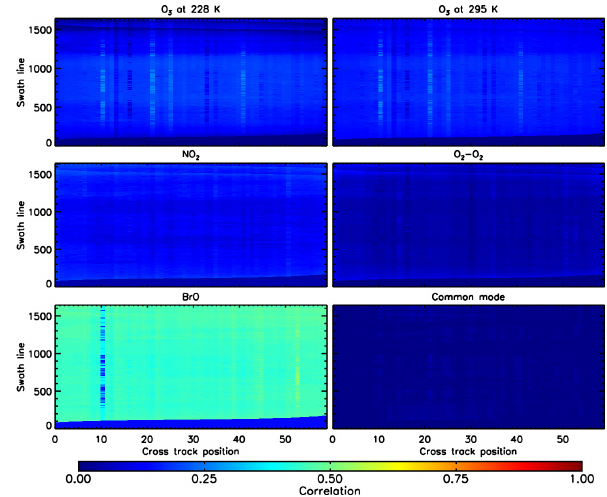
Figure 2. Correlations of H 2 CO with the rest of molecules con- sidered in the spectral fitting and the common mode spectrum for Orbit 8537 (21 February 2006 overpass over Africa and